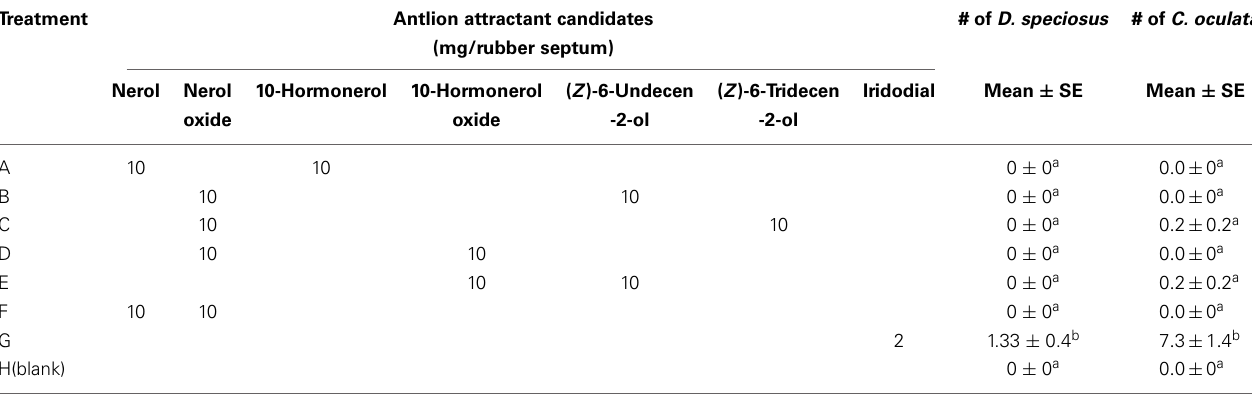
Table 1 | Mean trap catches (#/trap/collection; N = 9) of the antlion, Dendroleon speciosus , and the golden-eyed lacewing, Chrysopa oculata , to previously reported antlion semiochemical candidates and the green lacewing pheromone, iridodial; July 28th to September 16th, 2010, Spokane, WA, USA.